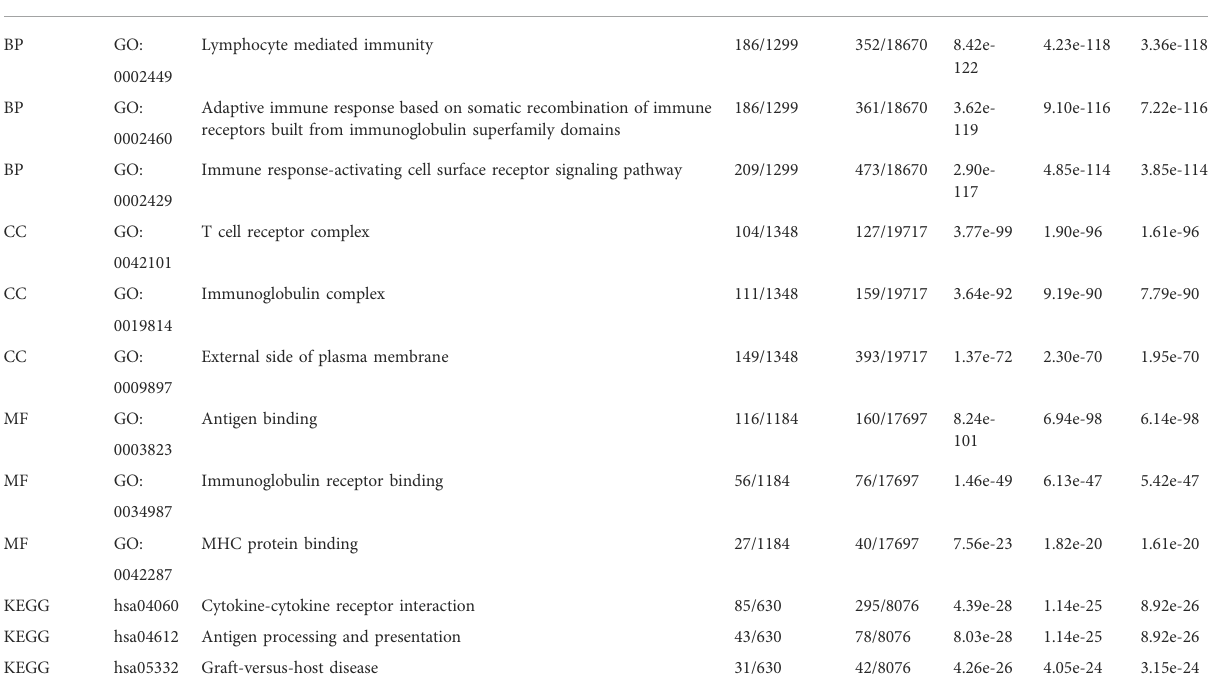
TABLE 2 GO-KEGG analysis of PD-1/PD-L1/CTLA-4 intersection co-expression genes. Ontology Id